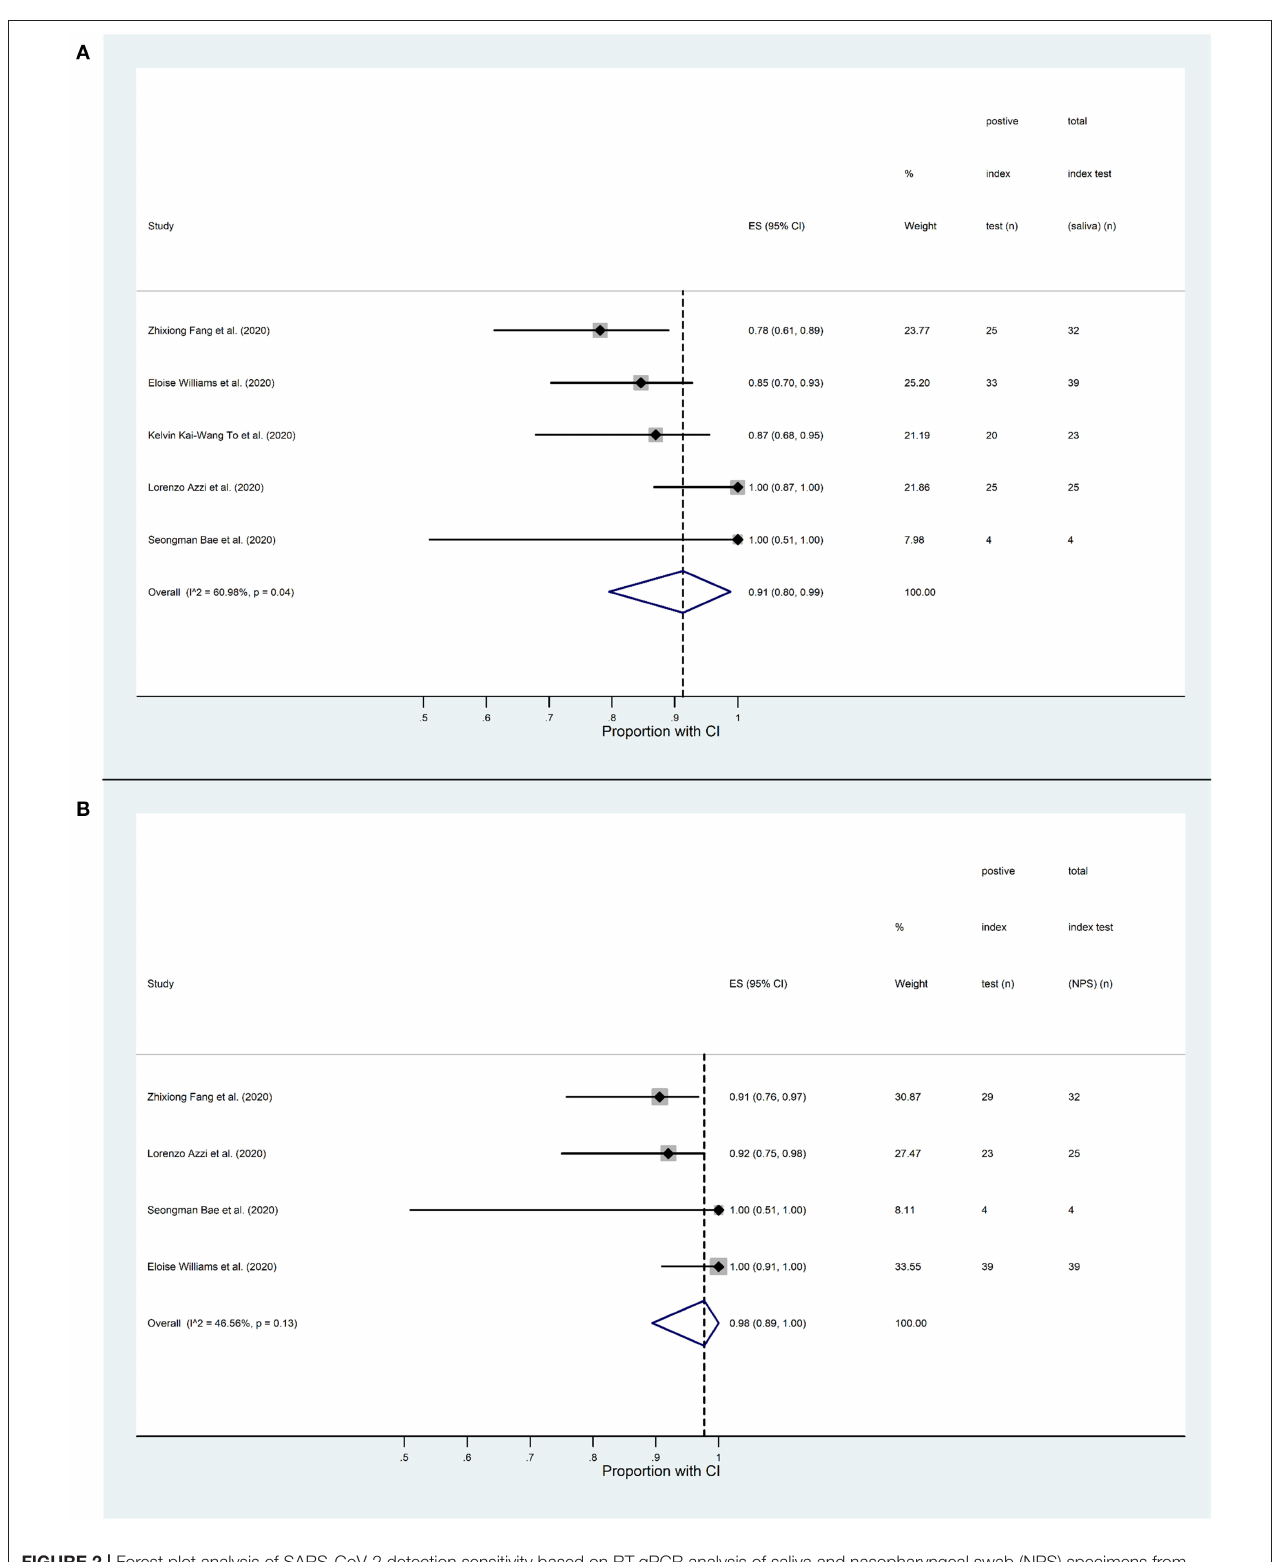
FIGURE 2 | Forest plot analysis of SARS-CoV-2 detection sensitivity based on RT-qPCR analysis of saliva and nasopharyngeal swab (NPS) specimens from COVID-19 patients. (A) Proportion of positive saliva tests in the five studies included in the quantitative analysis, ranging from 0.78 to 1. The overall proportion in the pooled data is 0.91 (CI 0.80–0.99). The I 2 value (60.98%, p = 0.04) indicates a moderate level of statistical heterogeneity. (B) Proportion of positive NPS tests in the four studies included in the quantitative analysis, ranging from 0.91 to 1. The overall proportion in the pooled data is 0.98 (CI 0.89-1). The I 2 value (46.56%, p = 0.13) indicates a low level of statistical